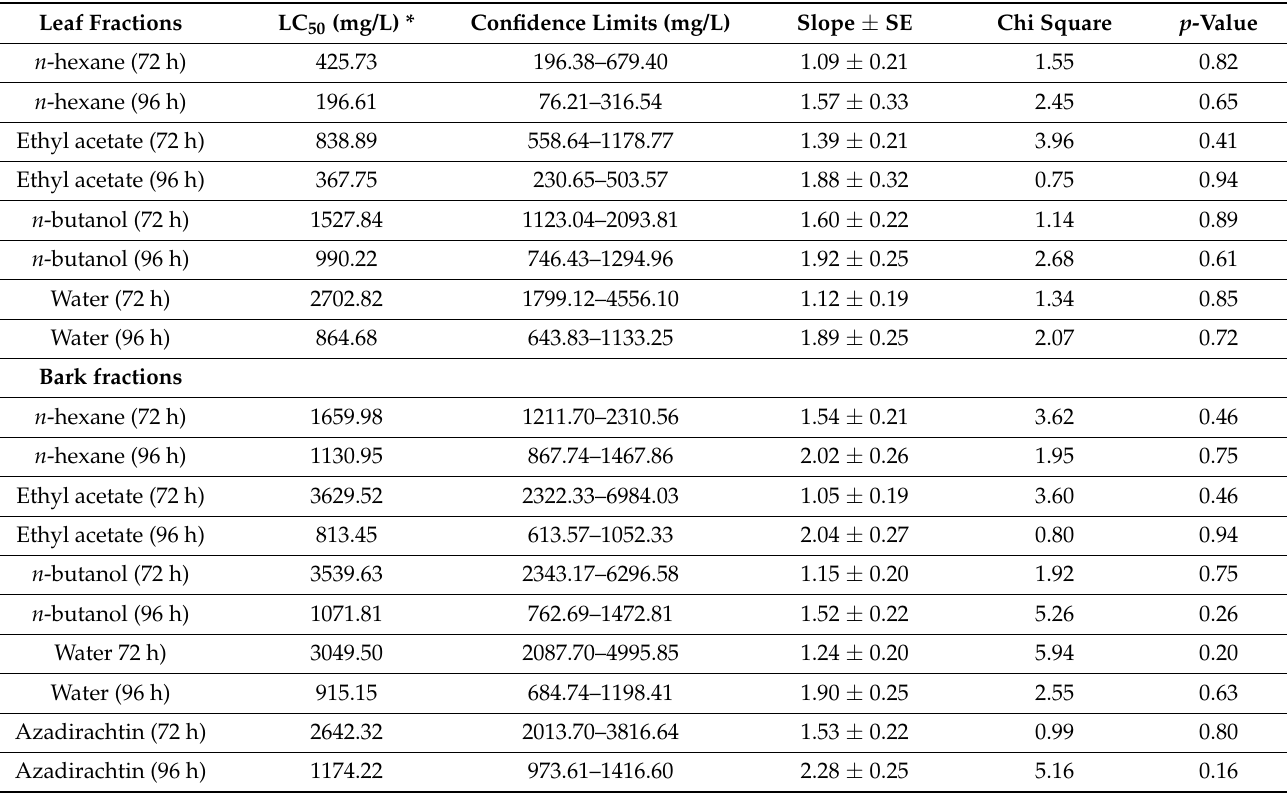
Table 4. Efficacy of fractions of Triadica sebifera leaves and bark against Aphis craccivora .